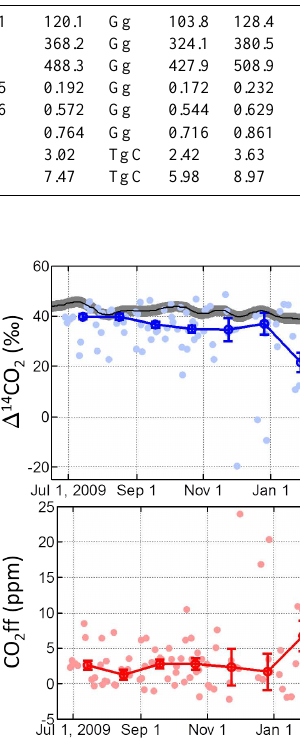
Fig. 2. Time series of 14 CO 2 (a) and CO 2 ff (b) from 145 discrete whole air samples (filled circles) collected at the BAO tower. Uncer- tainty in each 14 CO 2 measurement is ± 2.2‰, which translates to an uncertainty in each CO2ff observation of 1.2ppm (see Sect. 3.1). Thirty day binned medians are shown as open circles in both (a) and (b) , with error bars representing the standard error of the mean (1 σ ) for each 30 day bin. Also shown in (a) is the 14 CO 2 background as observed at NWR (black line) (Turnbull et al., 2007; Lehman et al.,2013), with the uncertainty envelope represented by the grey shaded